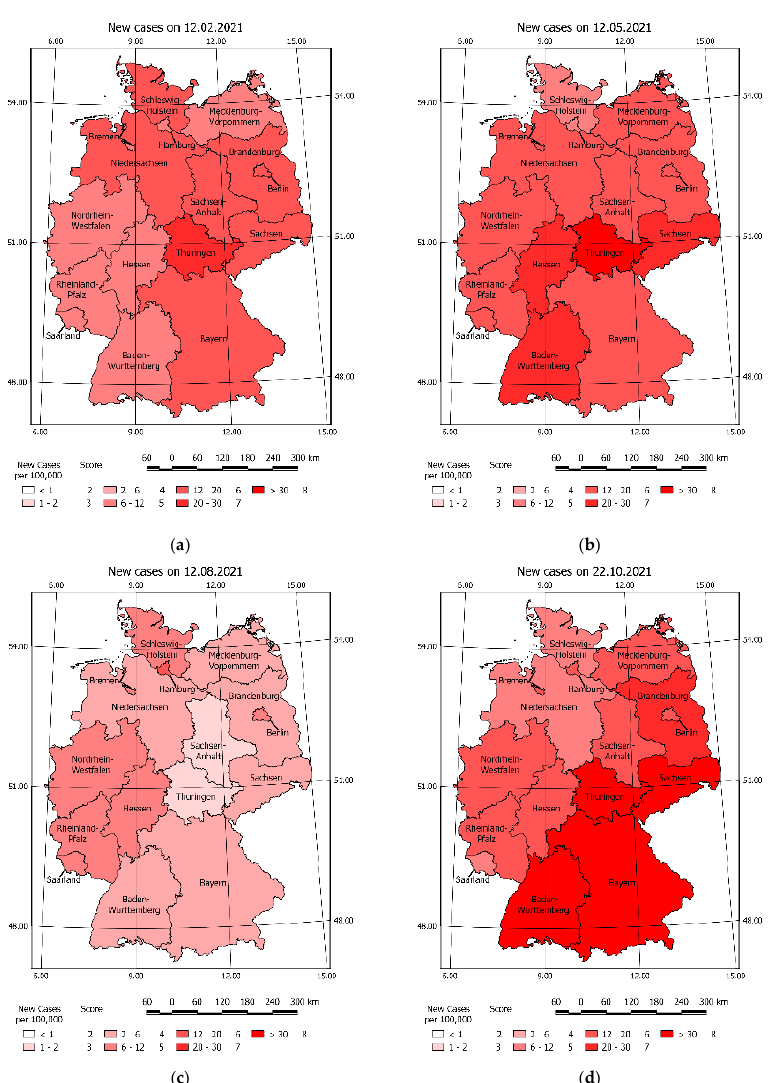
Figure A1. New cases of COVID-19 on selected days: ( a ) 04 March 2020 ( b ) 12 May 2020 ( c ) 12 Au- gust 2020 ( d ) 12 November 2020.